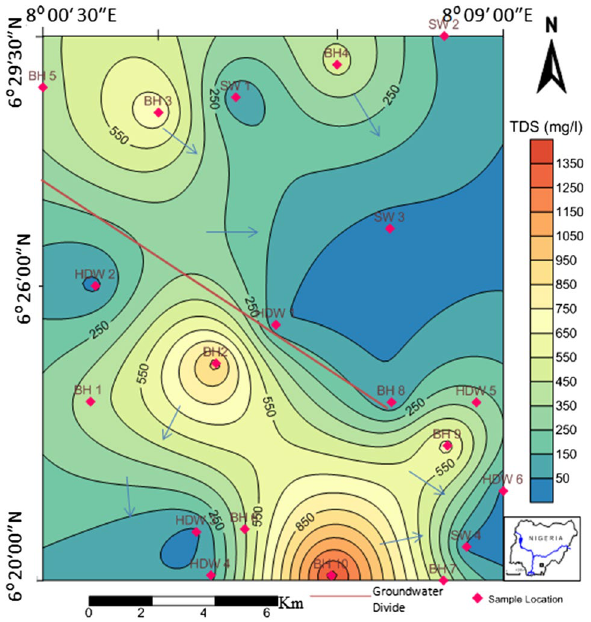
Fig. 7 Map showing dispersion trend of total dissolved solutes (TDS). Note : NW–SE-trending line indicates the groundwater